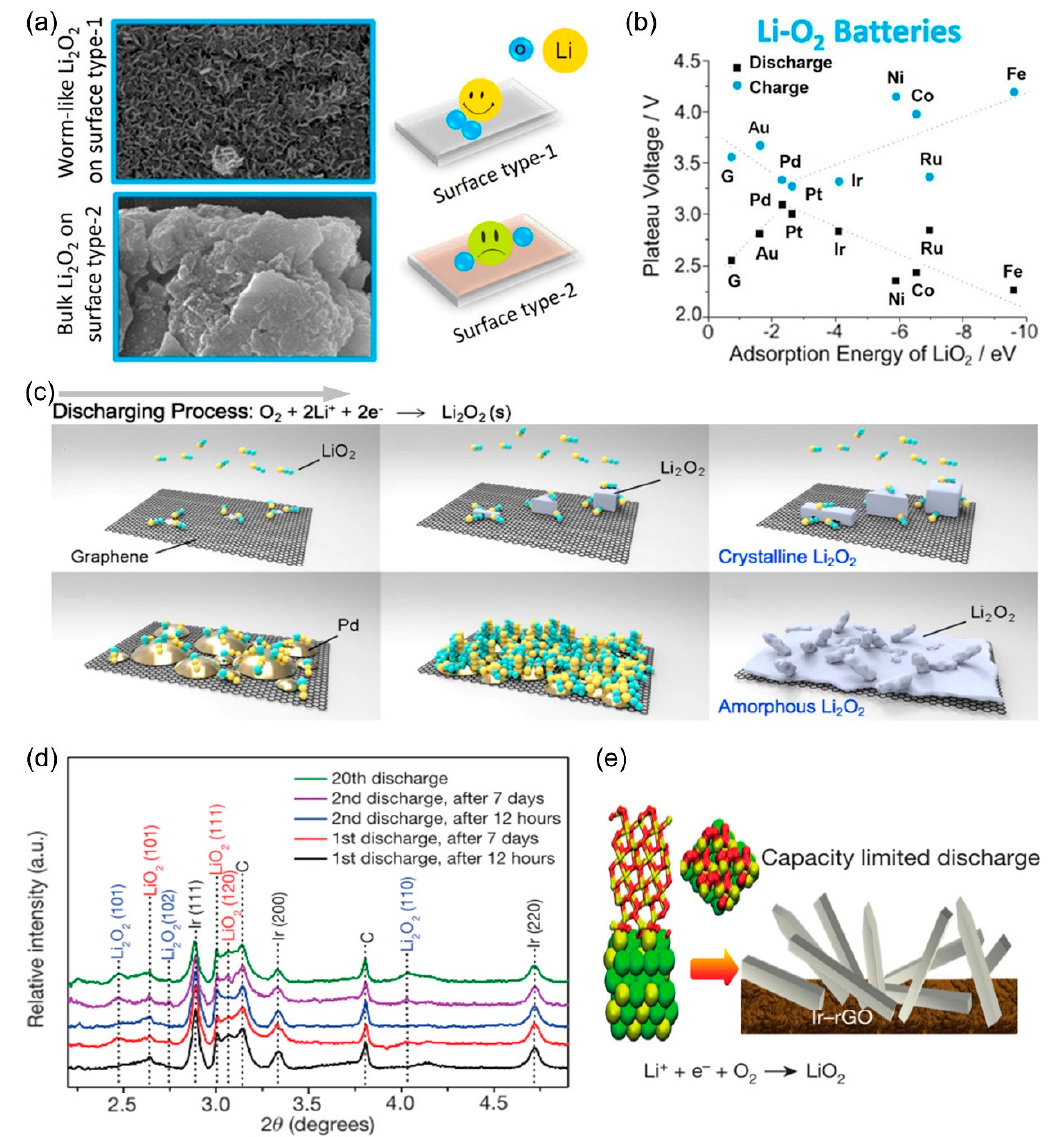
Figure 4. ( a ) Li 2 O 2 with different morphologies formed on different positive electrode surface types. ( b ) The volcano shape relationship between charge/discharge voltage plateau and adsorption energy of LiO 2 on the positive electrode surfaces. ( c ) The growth model of Li 2 O 2 on graphene and Pd coated graphene. ( d ) The HE-XRD patterns of discharge product on Ir-rGO as a function of ageing time. ( e ) Schematic illustration for the lattice matching between Ir 3 Li and LiO 2 . ( a,b ) Reproduced with permission from Ref. [72], copyright 2017, American Chemical Society. ( c ) Reproduced with permission from Ref. [73], copyright 2016, American Chemical Society. ( d,e ) Reproduced with permission from Ref. [84], copyright 2016, Nature Publishing Group.